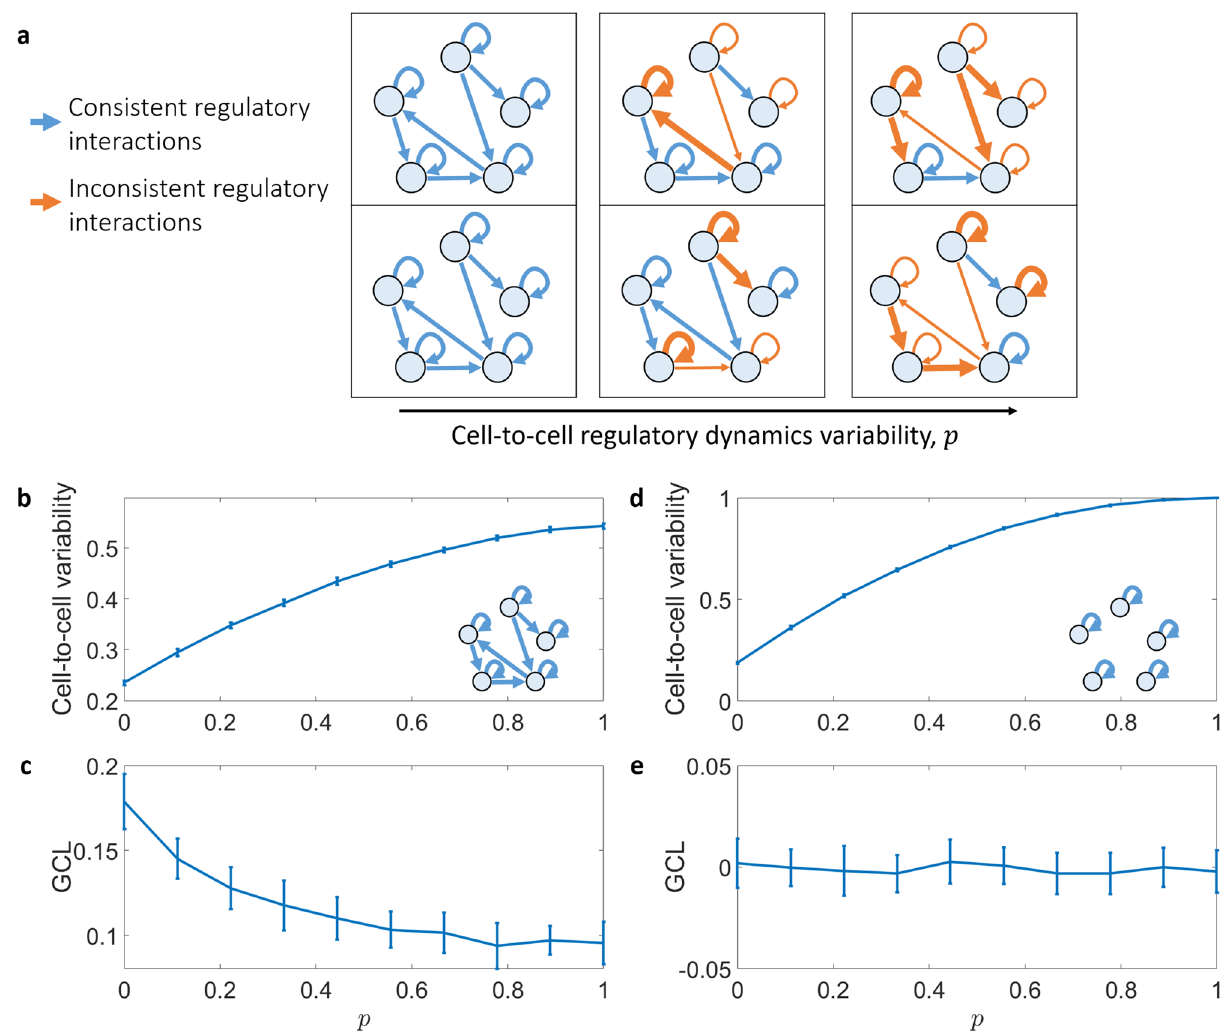
Figure 1. The effect of heterogeneous regulatory dynamics on the cell-to-cell variability and gene-to-gene coordination. ( a ) Schematic illustration of gene regulatory networks (GRNs) of two different cells. The weight of each gene–gene interaction and self-regulatory interaction (blue arrows) is replaced with a random value (orange arrows) with probability p . For p = 0 , both cells have the same GRNs. ( b , c ) Cell-to-cell variability and GCL score as a function of p for a cohort of simulated cells X ∗ N × M . The cell-to-cell variability was calculated as the average dissimilarity between all cell pairs, defined as one minus the Spearman correlation. ( d , e ) Same analysis as in ( b , c ), but with GRNs that have only self-regulation term, i.e., no gene–gene interactions. For these figures, we have M = 100 cells and N = 200 genes for each data point. The data points and error bars represent mean and standard deviation over 20 realizations, and every GCL score is calculated for m = 50 different divisions. Unlike the cell-to-cell variability, the GCL can indicate the presence of gene–gene interactions in the underlying